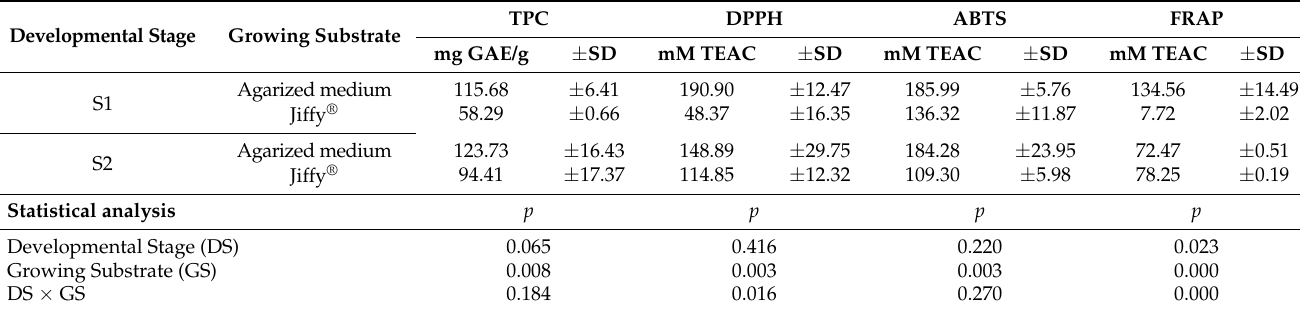
Table 1. Influence of sprout developmental stage and growing substrate on total phenolic contents (TPC), DPPH, ABTS and FRAP scavenging capacity of Moringa